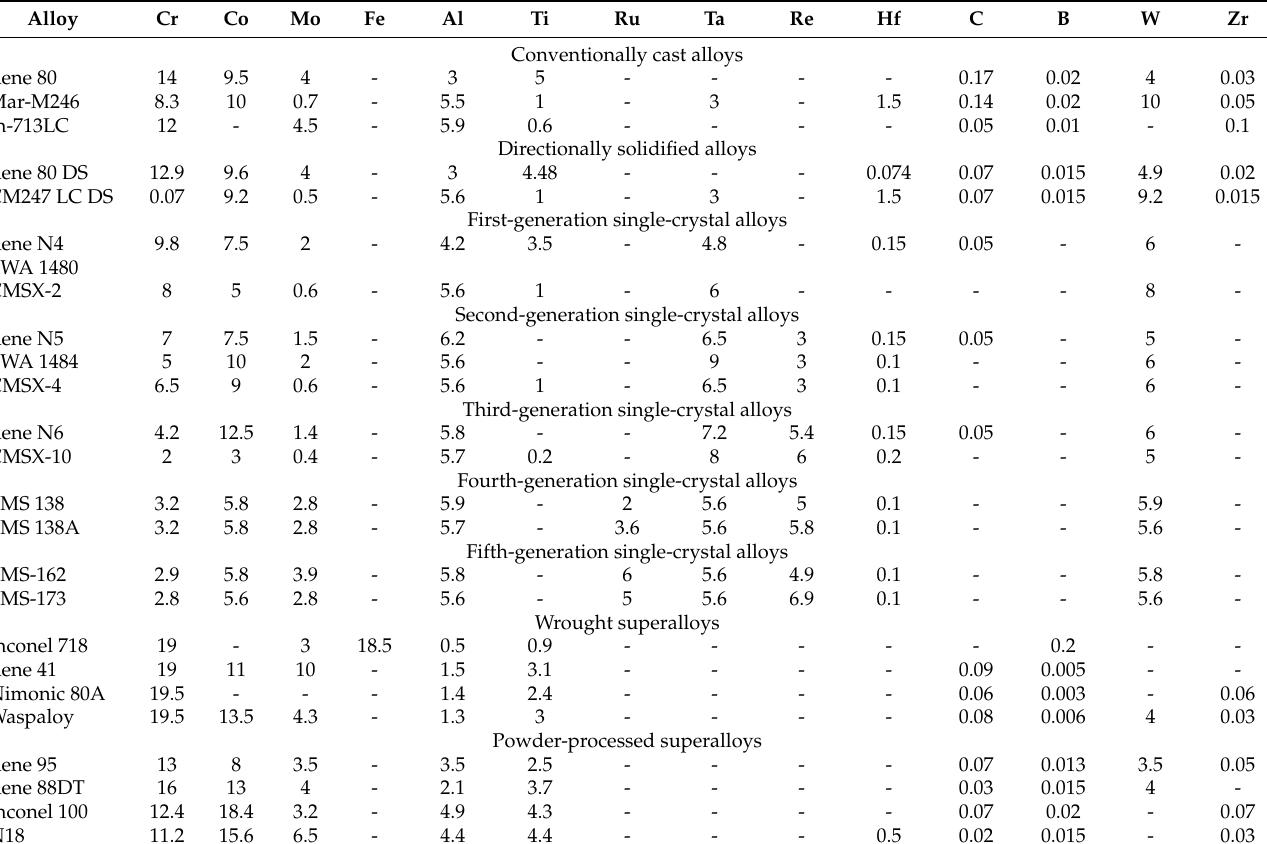
Table 1. Composition of commercial nickel-based superalloys (wt.%, bal. Ni)